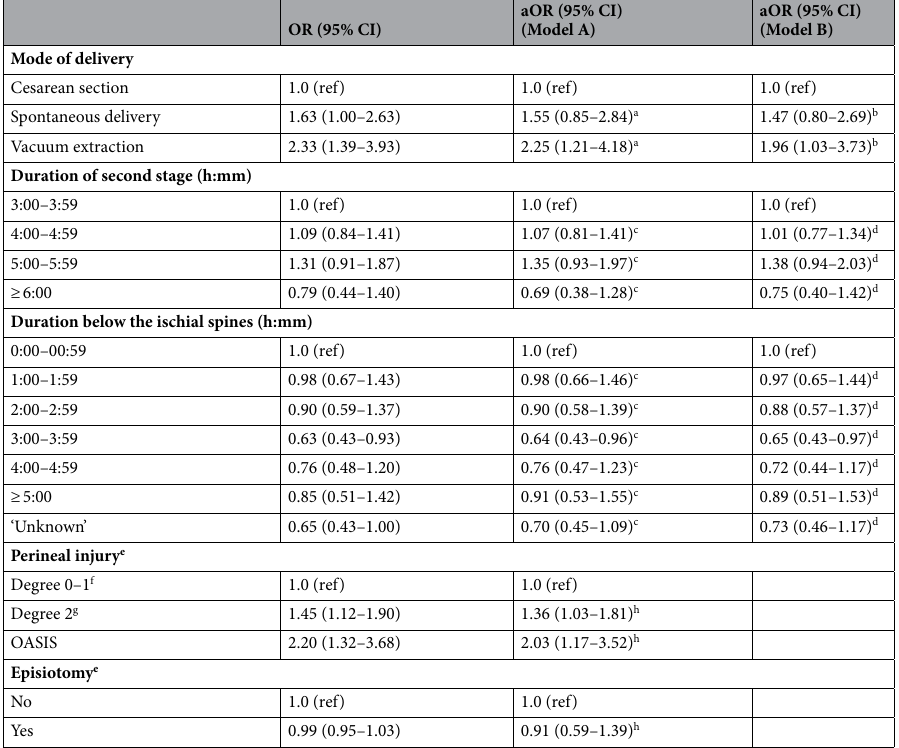
Table 3. Univariate and multivariate logistic regression for Wexner score ≥ 2. Unadjusted model: n = 1238 women. Model A: Confounders adjusted for according to the Model A DAG:s for the different exposures. Model B: Confounders and mediators adjusted for according to the Model B DAG:s for the different exposures. a Adjusted for age, BMI, Mb Crohn/Ulcerative colitis, second stage duration, duration of fetal station below the ischial spines, fetal position, birthweight, and head circumference (Supplementary Fig. S1 DAG 1 model A), n = 1132. b Adjusted for age, BMI, second stage duration, duration of fetal station below the ischial spines, perineal injury, birthweight, and head circumference (Supplementary Fig. S1 DAG 1 model B), n = 1175. c Adjusted for age, BMI, birthweight, and head circumference (Supplementary Fig. S1 DAG 2 model A), n = 1175. d Adjusted for age, BMI, mode of delivery, perineal injury, birthweight, and head circumference (Supplementary Fig. S1 DAG 2 model B), n = 1175. e Vaginal deliveries only, n = 1204. f No diagnosis, 1st degree or isolated vaginal tear. g 2nd degree including episiotomy. h Adjusted for age, BMI, mode of delivery, second stage duration, duration of fetal station below the ischial spines, fetal position, birthweight, and head circumference (Supplementary Fig. S1 DAG 3), n = 1075.